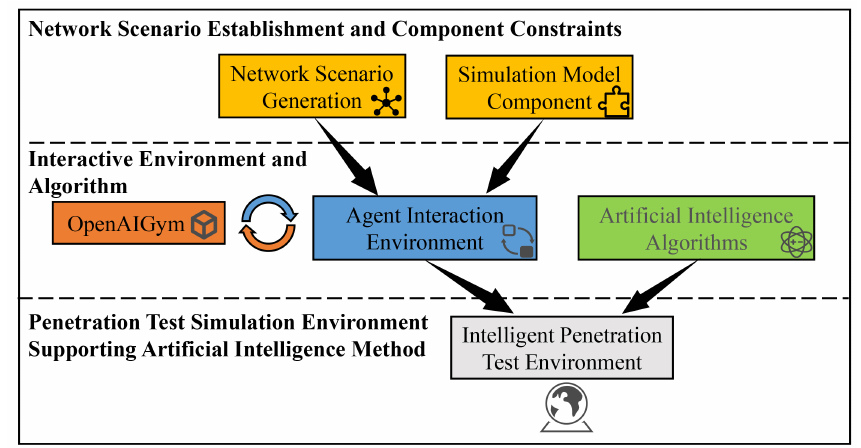
Figure 9. Composition of intelligent penetration test simulation